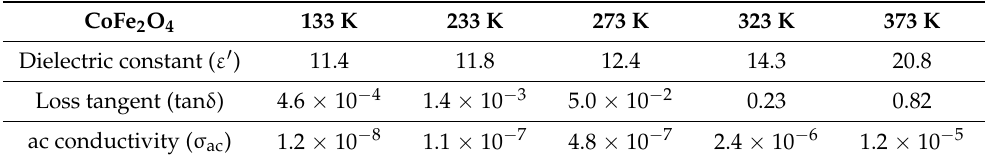
Figure 5. Dielectric constant versus frequency curve of CeFe 2 O 4 nanostructures at different temperatures. Table 2. Dielectric constant ( ε ’), loss tangent (tan δ ), and ac conductivity ( σ ac ) CoFe 2 O 4 nanostruc- tures recorded at 1.0 MHz.